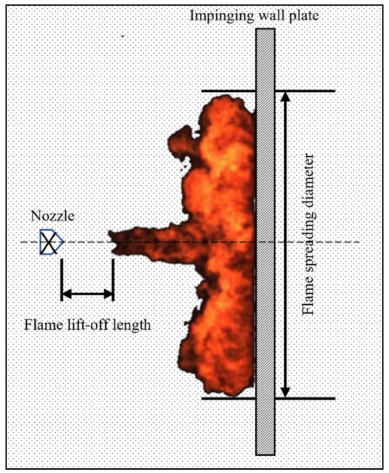
Figure 11. The geometric parameters of the flame.